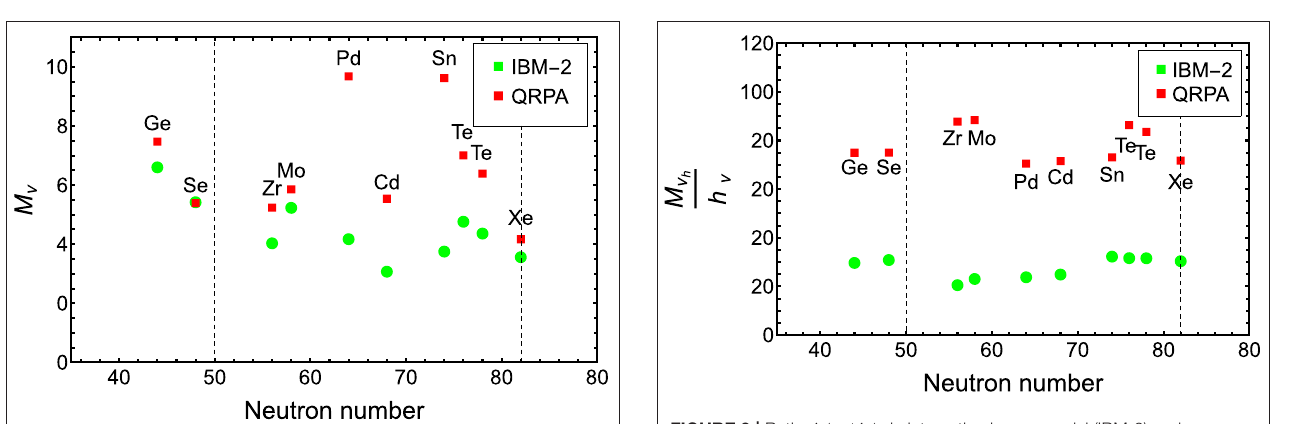
/ M ν in interacting boson model (IBM-2) and FIGURE 3 | Ratio M ν h quasiparticle random phase approximation (QRPA) using same form factor charges, same overall sign for tensor matrix elements, and the convention that M ν , M ν > h